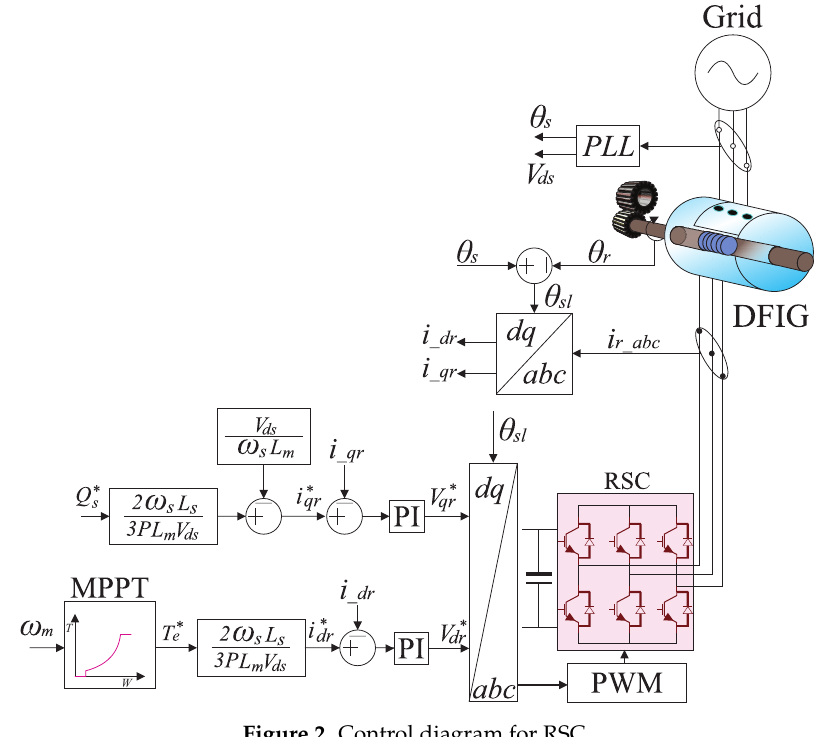
Figure 2. Control diagram for